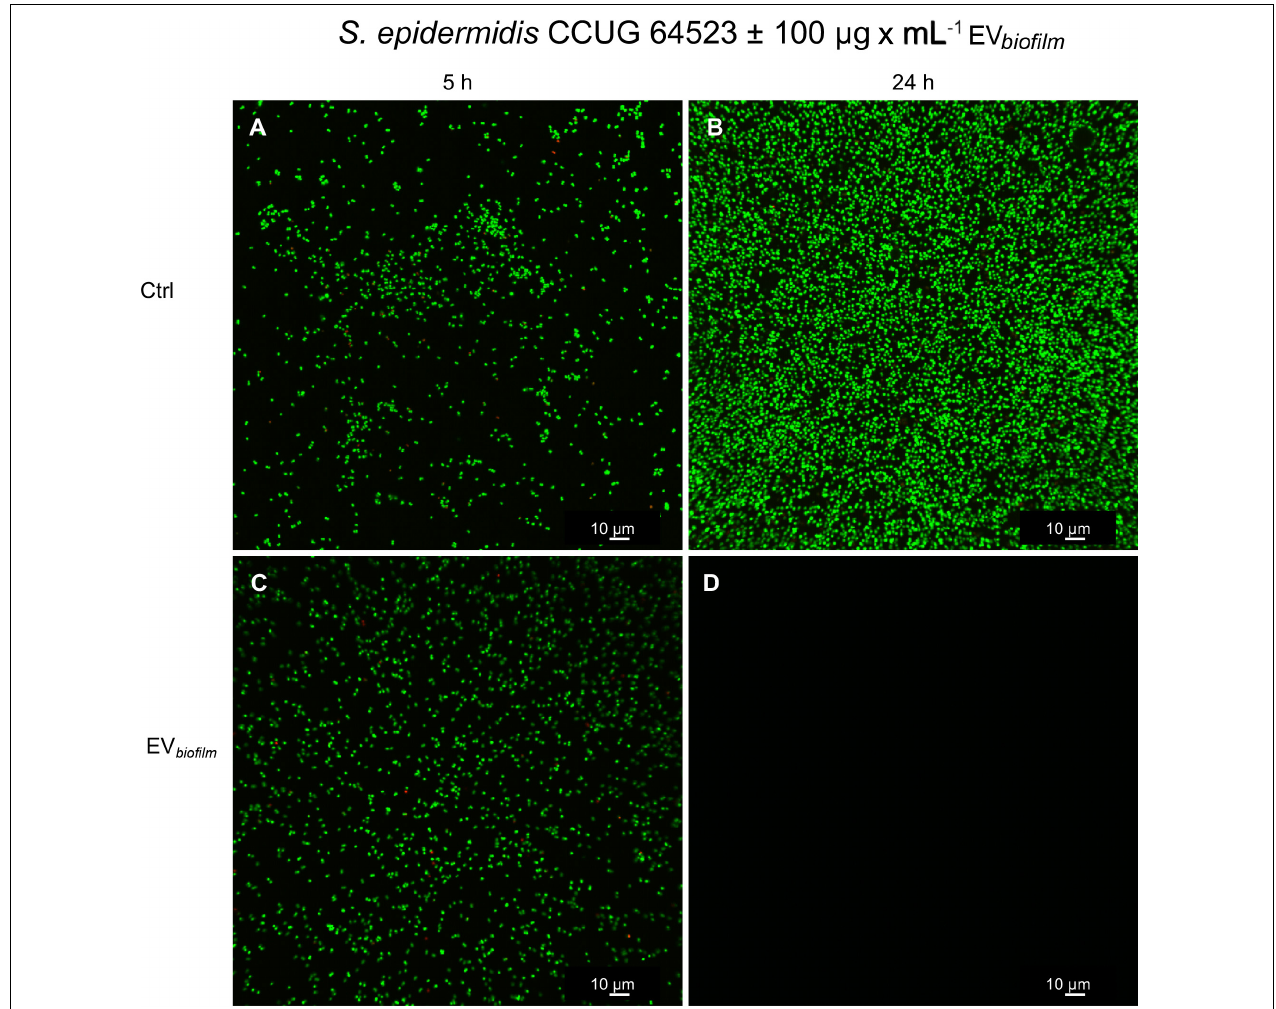
FIGURE 8 | Confocal laser-scanning micrographs showing the adhesion of S. epidermidis CCUG 64523 cells to glass slides. (A,B) Unstimulated Ctrl cells cultured for (A) 5 h and (B) 24 h and (C,D) cultures supplemented with EVs (100 µ g × mL − 1 ) derived from the biofilm-producing/GEN R strain S. epidermidis ATCC 35984 (EV biofilm ) and cultured for (C) 5 h and (D) 24 h. Bacterial cells were stained with SYTO9; live cells were stained green, and propidium iodide was used to stain dead cells red. All images were taken using both channels. Mainly live (green) cells were observed, and only a few scattered dead (red) cells were found. Scale bar: 10 µ m.